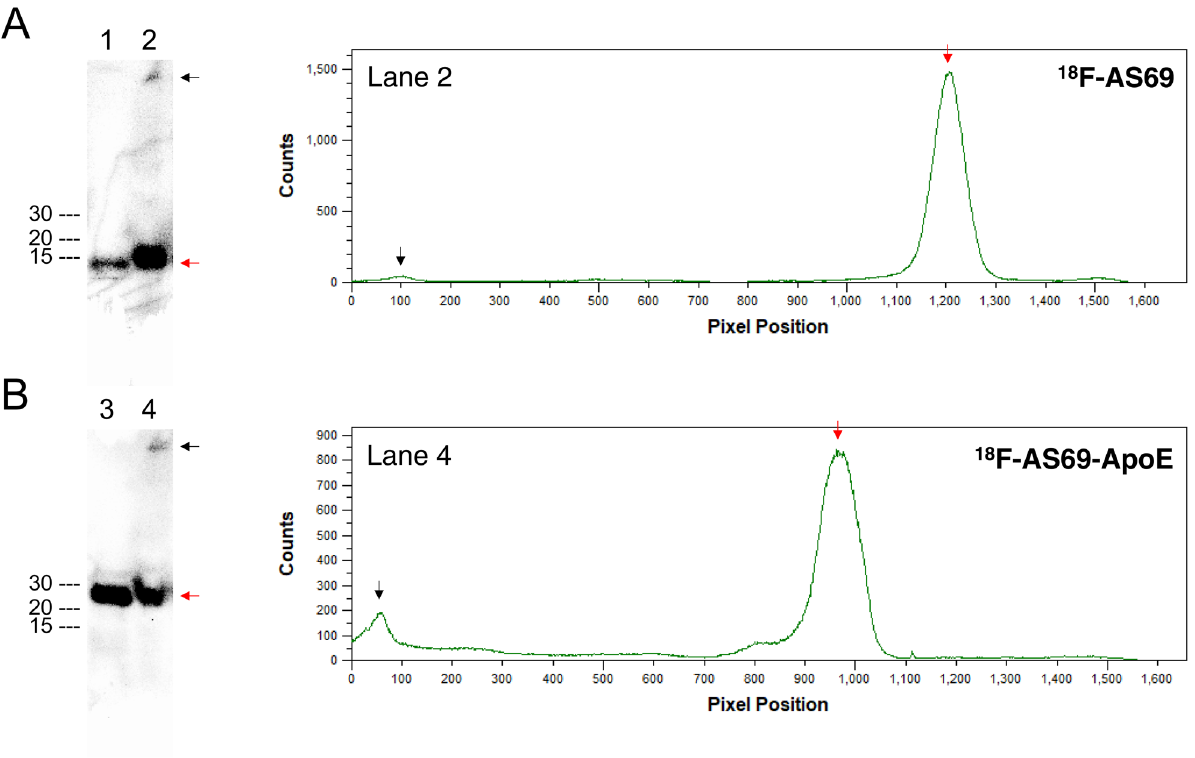
Figure 5. In vitro stability of 18 F-AS69 and 18 F-AS69-ApoE in mouse plasma. Results for 18 F-AS69 (A, 14 kDa) and 18 F-AS69-ApoE (B, 22 kDa). The figure presents autoradiographs from gels following SDS-PAGE analysis of 18 F-AS69 and 18 F-AS69-ApoE samples incubated for 60 min at 37 °C in PBS (lane 1 and 3) or mouse plasma (lane 2 and 4), and image analysis of lanes 2 and 4. Red arrows indicate the major products ( 18 F-AS69 in A, 18 F-AS69-ApoE in B) and black arrows indicate the radioactivity appeared at the top of each lane. The radioactivity of the samples was 18.5–37.0 kBq/10 µL when they were applied. Full-length autographic images and gels were shown in Fig.